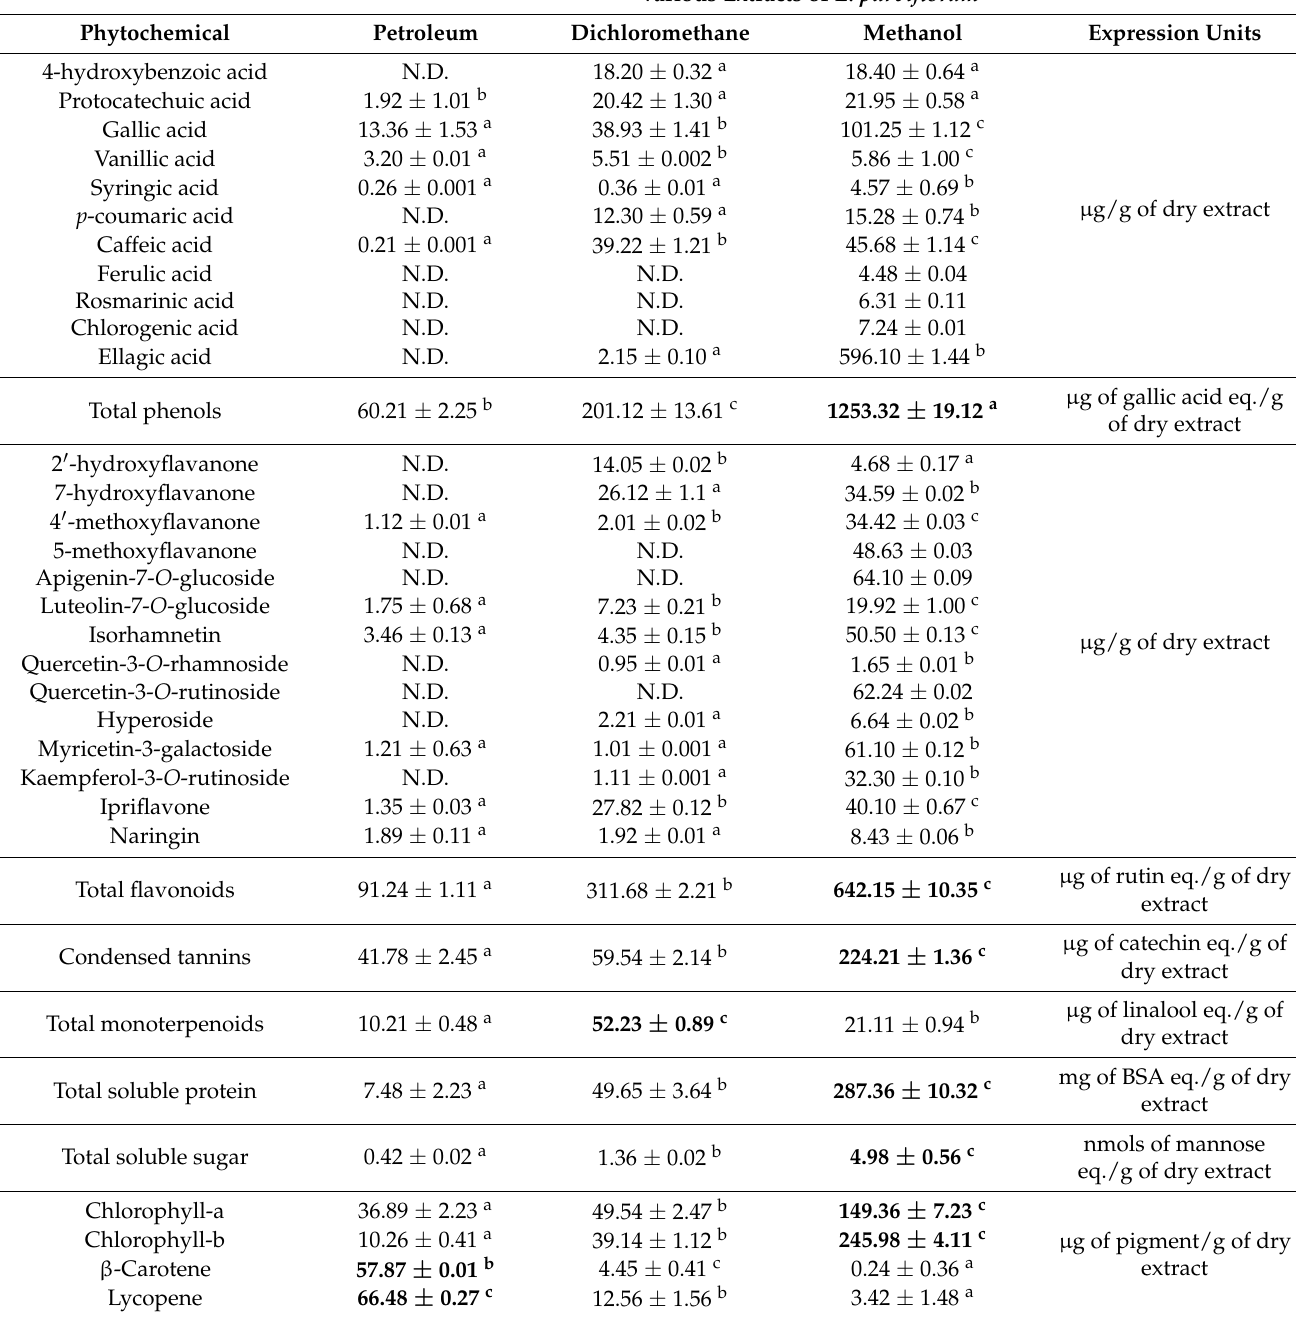
Table 2. Quantitative data demonstrating the phytochemical content of petroleum, dichloromethane, and methanolic extracts of E. parviflorum . N.D. indicates non-detectable metabolite levels; data are means of six independent experiments ± SD; all values with different superscript letters in a column are significantly different, while same superscript letters indicate no statistical significance, at p <